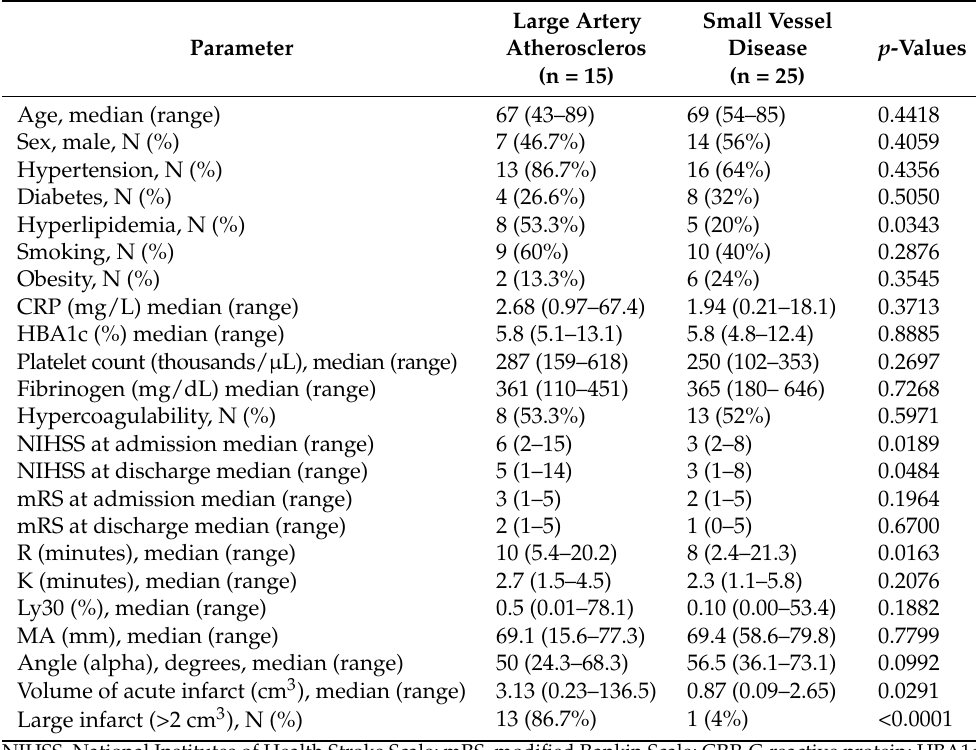
Table 5. Comparison of subpopulations with two etiologies of